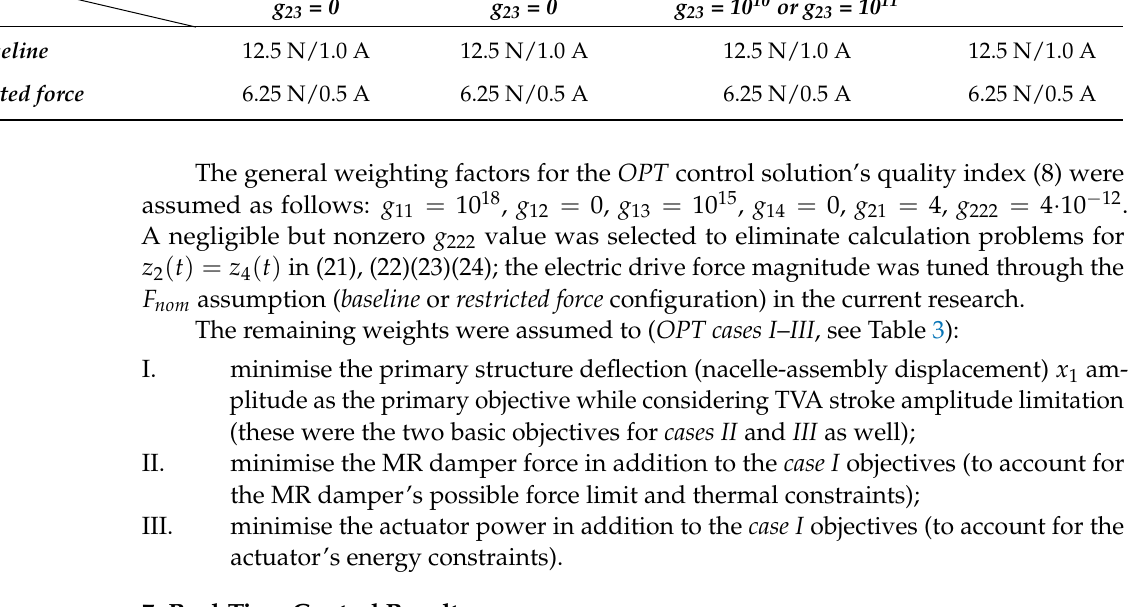
Table 3. The test cases: nominal actuator force F nom /maximum MR damper current i _ max . Control Configuration